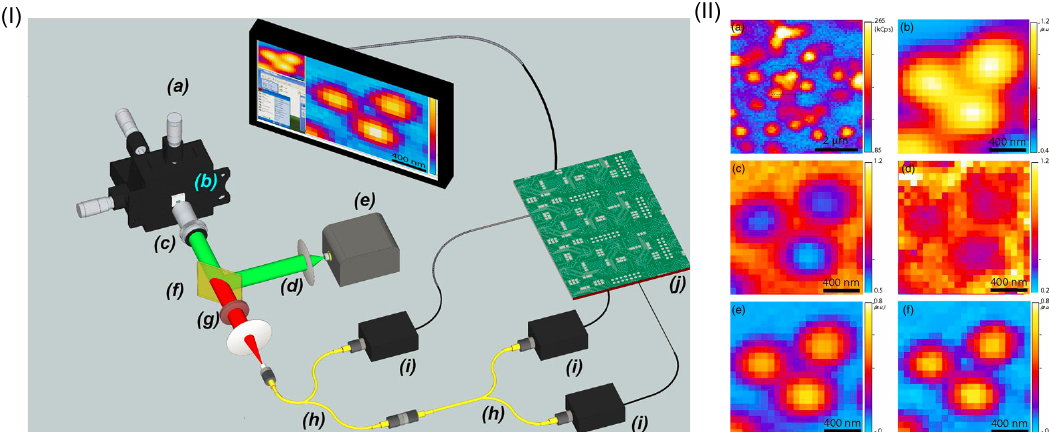
Figure 6. ( I ): Schematic of super-resolution confocal microscope for fluorescence imaging. Multi-photon coincidence counts are measured by using single-photon detectors configured in the tree structure with fiber beam splitters. ( II ): Three partially overlapped NV centers in the conventional intensity image ( a ) is selected, which cannot be clearly distinguished as seen in the zoom-in image ( b ). The antibunching effect of NV emitters is seen by employing second-order ( c ) and third-order ( d ) correlation measurement. After processing numerical calculation, the second-order ( e ) and third-order ( f ) cumulant function gives rise to super-resolution image, revealing three clearly distinguishable NV centers. The figure is reproduced with permissions from Ref. [38] of